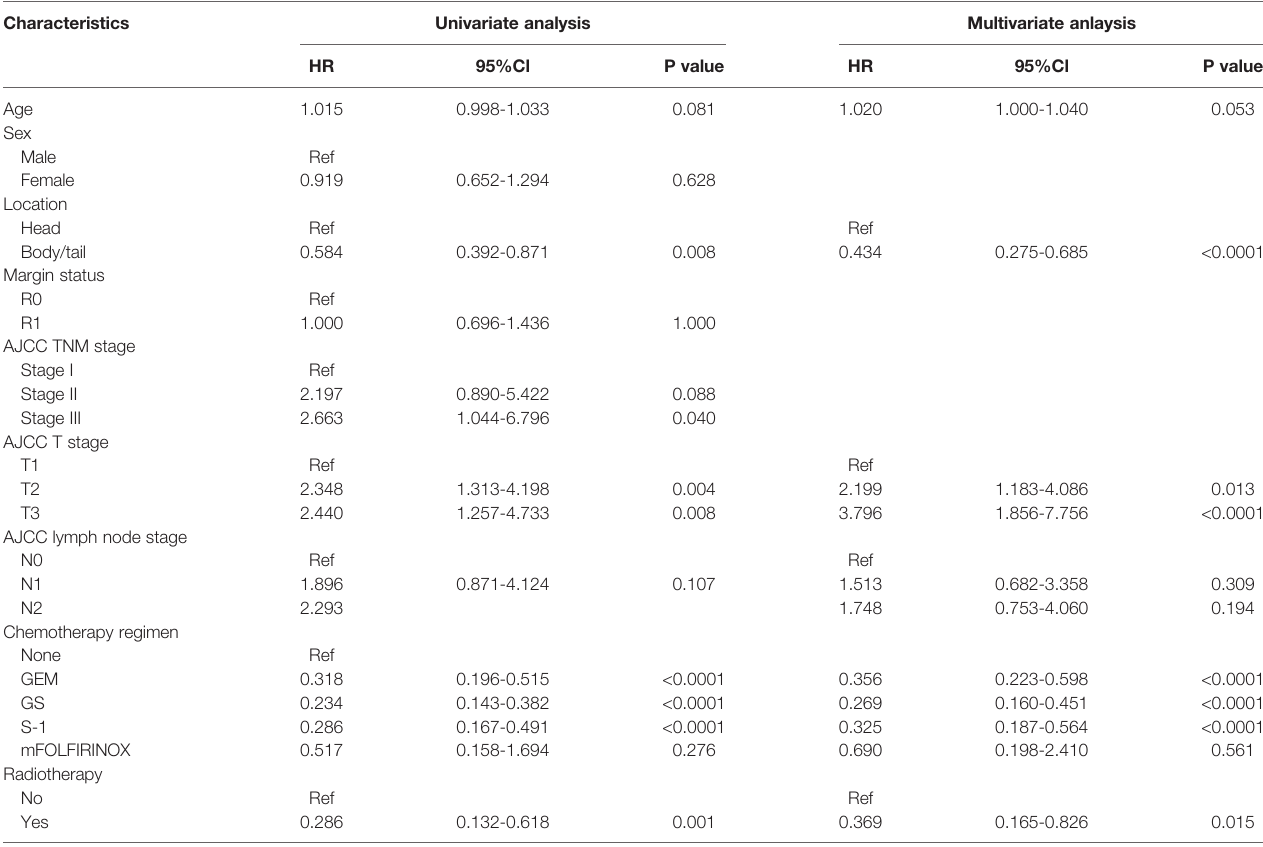
TABLE 2 | Cox proportional hazards regression analysis of the risk of death among 266 patients with lymph node metastasis or R1 resection after surgery for resectable pancreatic adenocarcinoma.